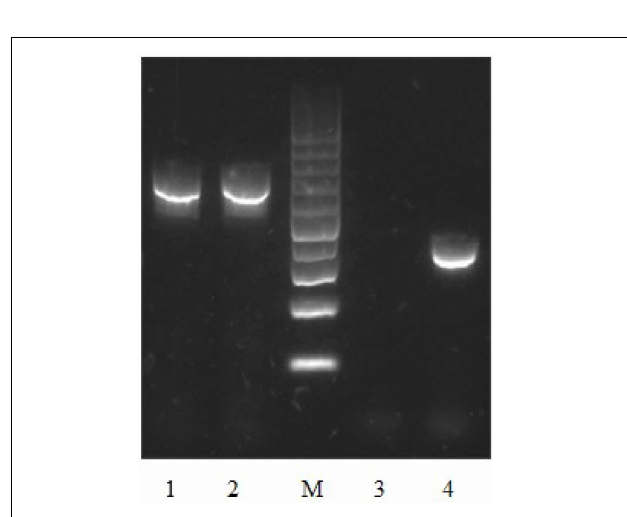
FIGURE 6 | Detection of vpa1307 transcript by RT-PCR in V. parahaemolyticus. V. parahaemolyticus was grown in LB and RNA was extracted after incubation with/without 35 μ M TPEN. 16S RNA was used as a loading control. Lane 1, 16S RNA (with TPEN); lane 2, 16S RNA (without TPEN); lane 3, vpa1307 (without TPEN); lane 4, vpa1307 (with TPEN); lane M, 100-bp maker (Thermo Scientific).